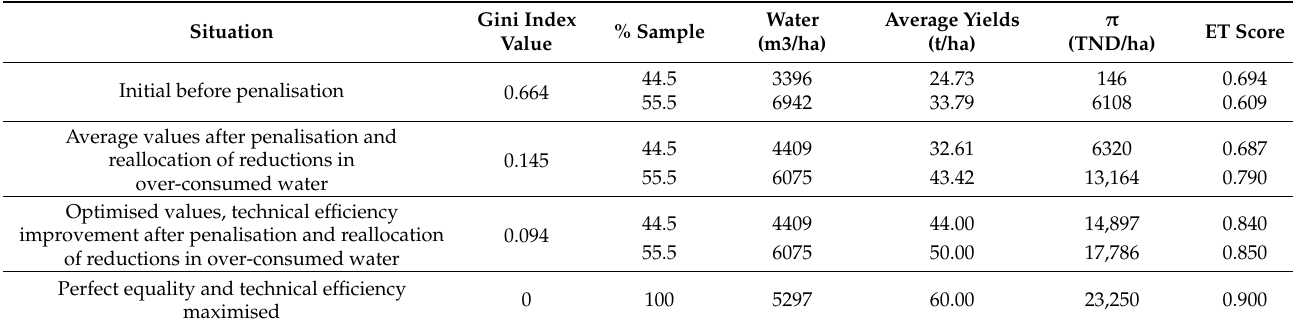
Table 5. Gini index